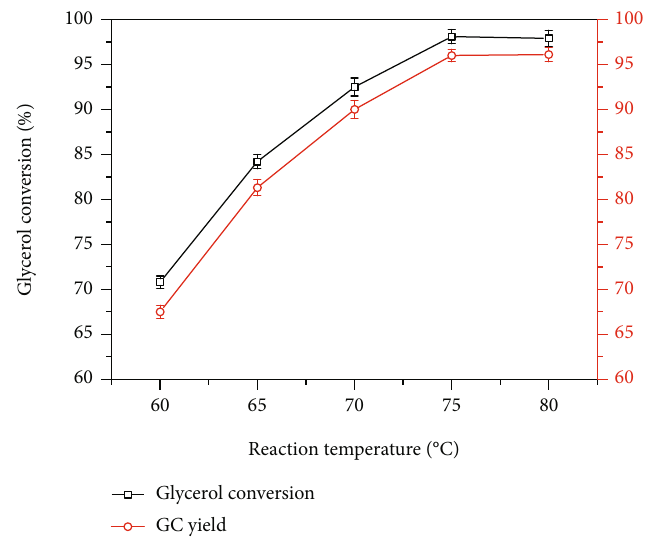
Figure 9: E ff ect of reaction temperature on glycerol conversion and GC yield.